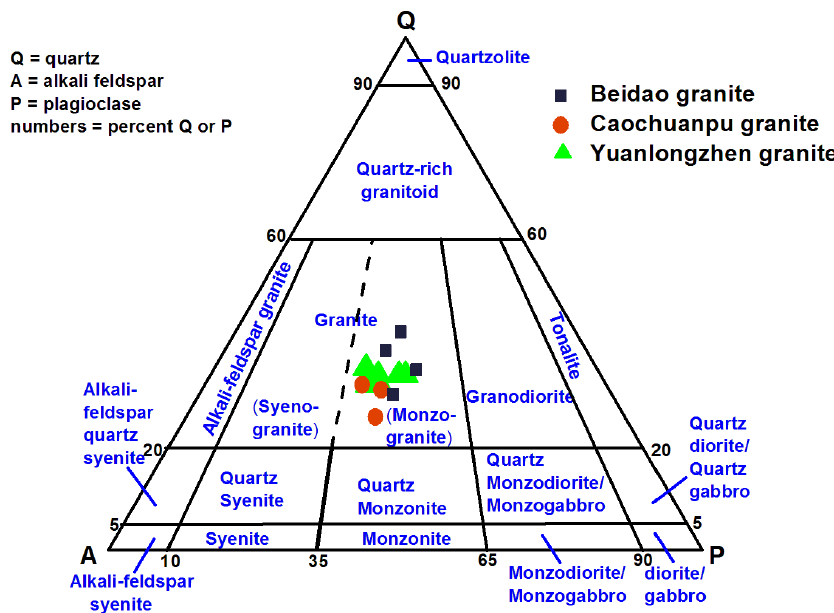
Figure 4. Modal amount (volume %) from the investigated granite samples from the Tianshui area are plotted in the IUGS classification diagram for plutonic igneous rocks after [50]. Modal abundances were determined using the point-counting method under the optical microscope.